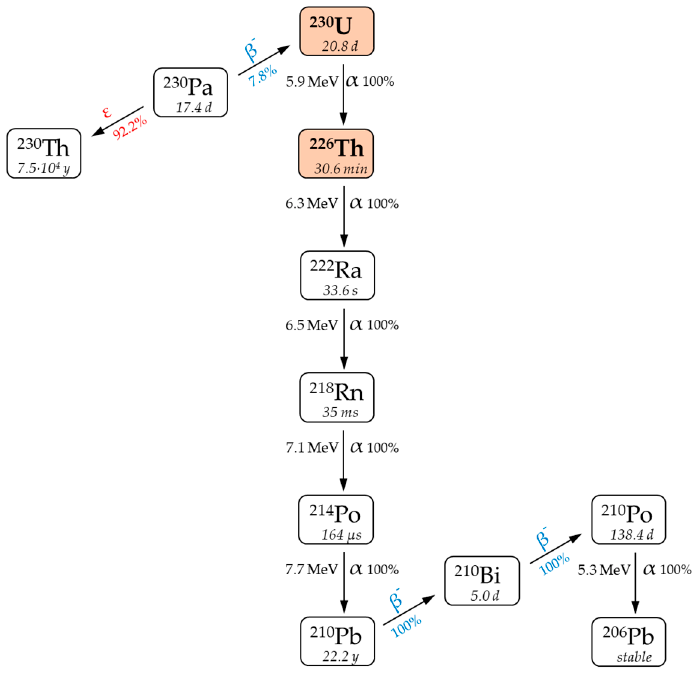
Figure 1. Decay chain of 230 Pa